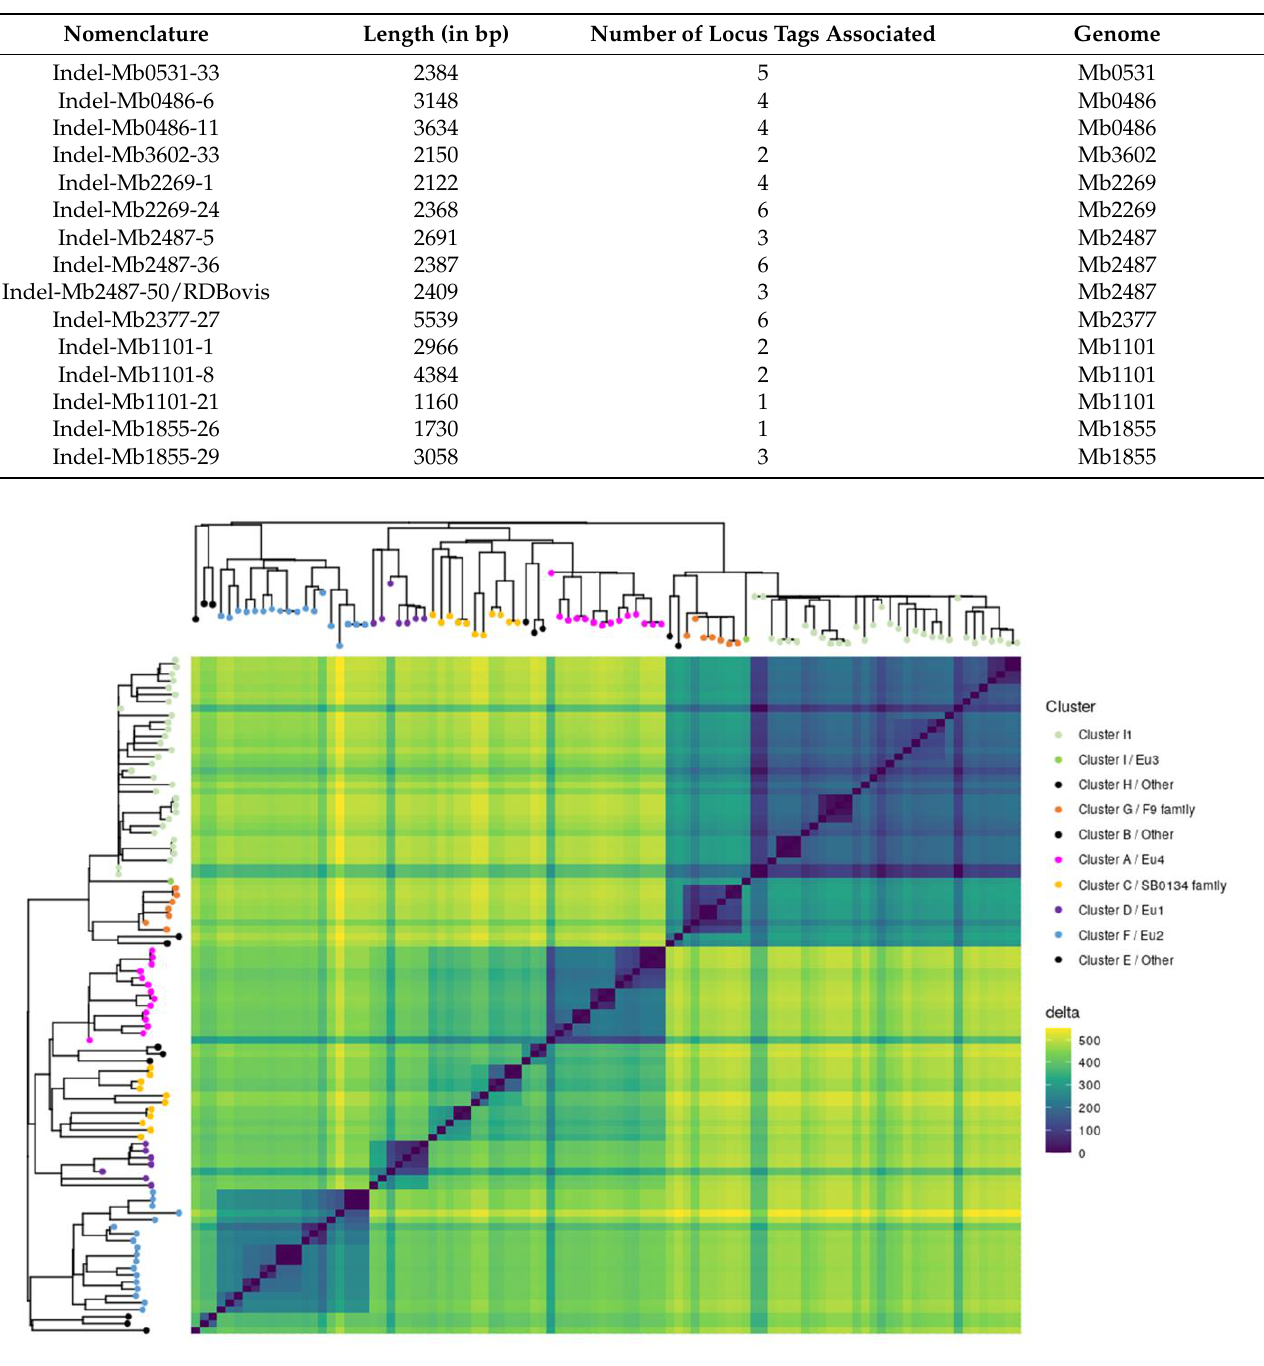
Figure 5. List of specific genetic events of the different M. bovis groups (Tables S4 and S5). The colors of the M. bovis groups are in accordance with the previously described clusters and lineage Hauer et al. 2019 [7] .